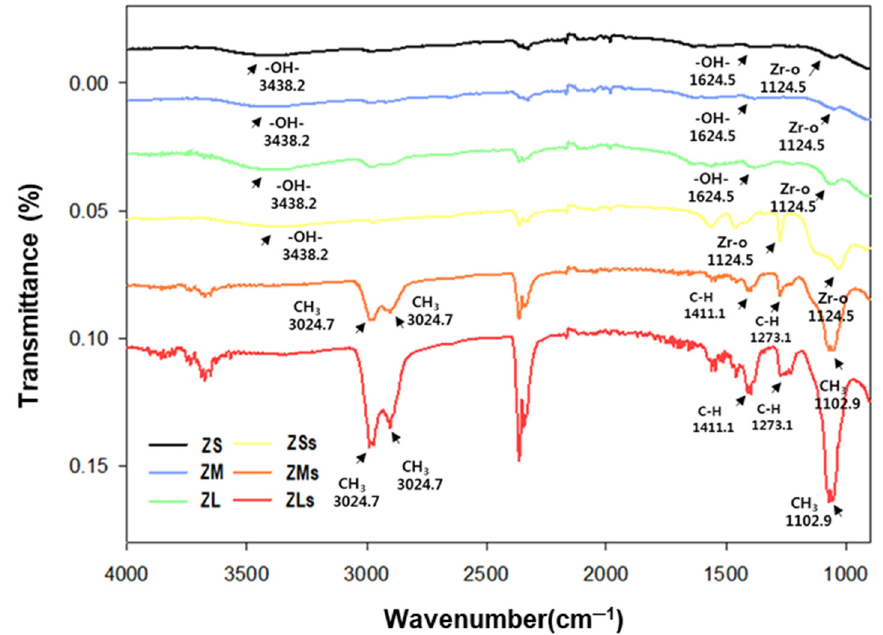
Figure 7. FT-IR spectra of various zirconia particles before and after silane coating.